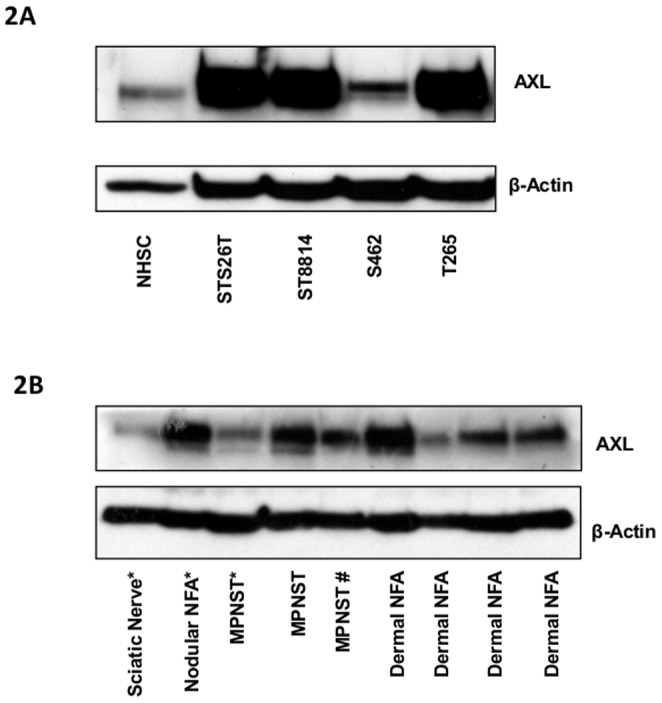
Increased protein expression of AXL in MPNST cell lines and human tumor samples.
A, the expression of AXL protein in the four MPNST cells by Western blotting. 2B, AXL protein expression in 3 MPNST samples, one nodular neurofibroma (a hard deeply located neurofibroma near the sciatic nerve), four dermal neurofibromas and the unaffected sciatic nerve from an NF1 patient was demonstrated by immunoblotting. Three of the samples marked with * were derived from the same patient. The other six samples are derived from six different patients. One MPNST sample marked with # was derived from a sporadic patient, without any family history or symptoms of NF1.